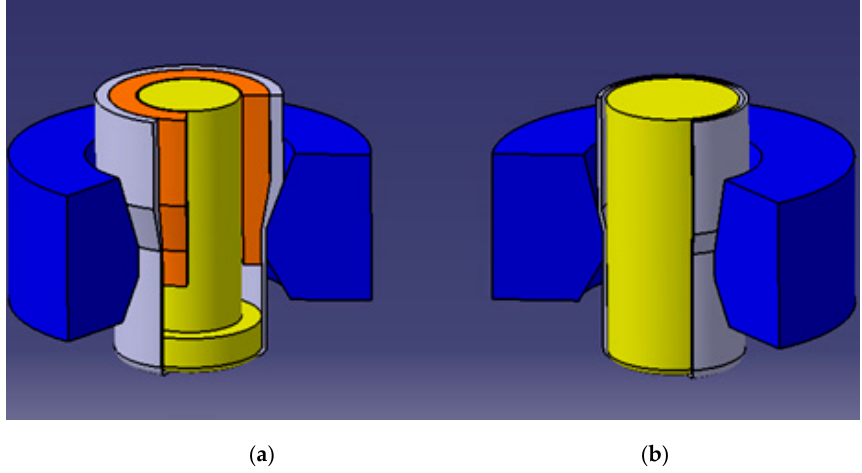
Figure 10. The drawing process modeling. Drawing over floating mandrel ( a ); drawing without a mandrel ( b ).